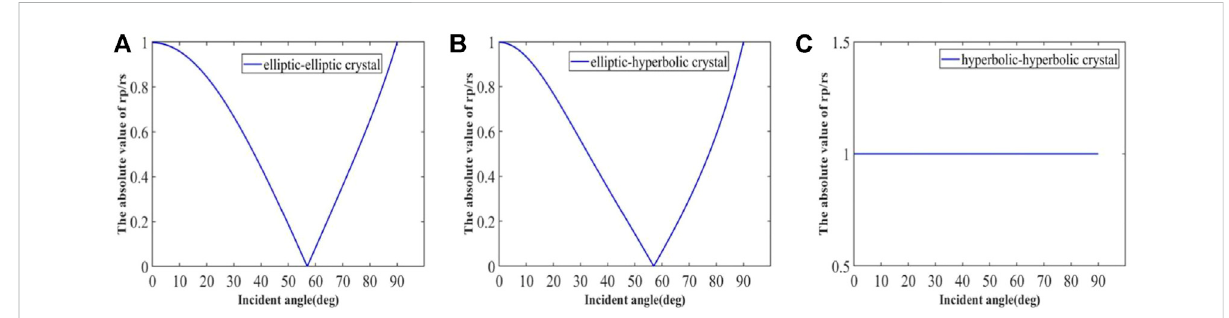
FIGURE 4 Curves of the value of | r p / r s | with respect to (A) : elliptic – elliptic crystal; (B) : elliptic – hyperbolic crystal; (C) : elliptic – elliptic crystal.